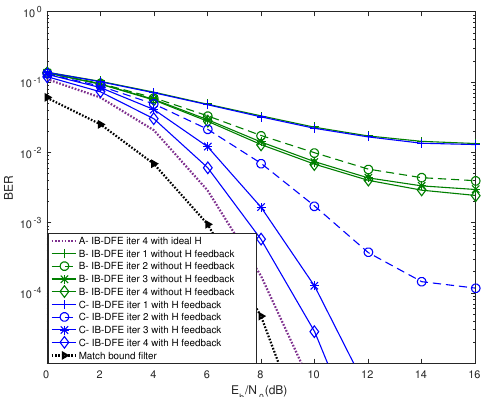
Figure 8. Comparison of the BER performance of the system based on two different methods to estimate